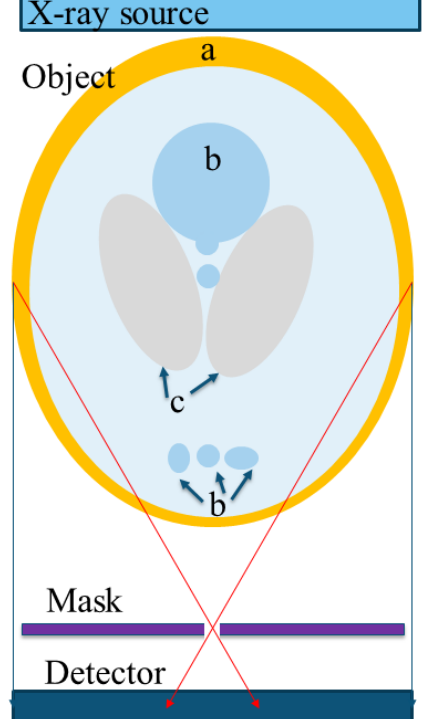
Figure 1. The simulation setup consists of an X-ray source, an object (a standard phantom or any other shape), a filter coding mask, and a flat panel detector. In this figure, the object is a Shepp–Logan Phantom, a standard test object of a head section which is composed of: ( a ) skull, ( b ) glandular tissue, and ( c ) soft tissue. The red arrows represent two radiation rays passing through one of the pinholes in the mask.